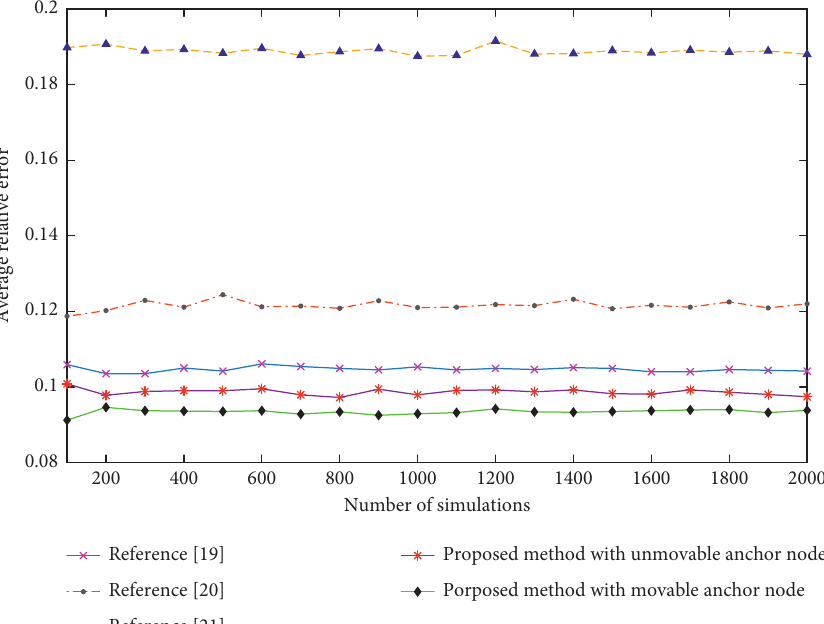
Figure 1: The relative error with different number of simulations.